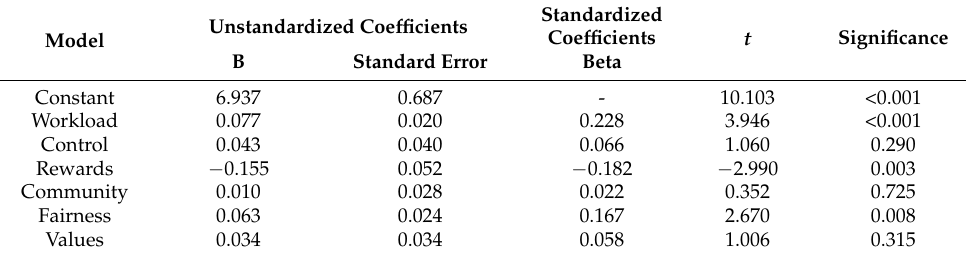
Table 5. Depersonalization and areas of work life.